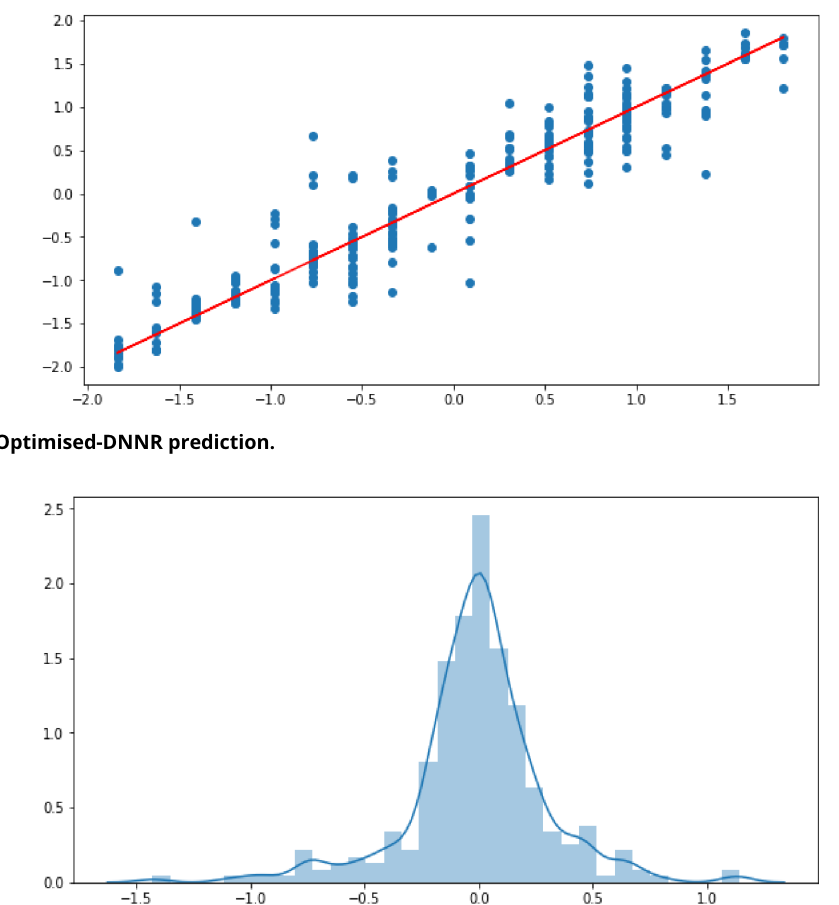
Figure 10. Optimised-DNNR